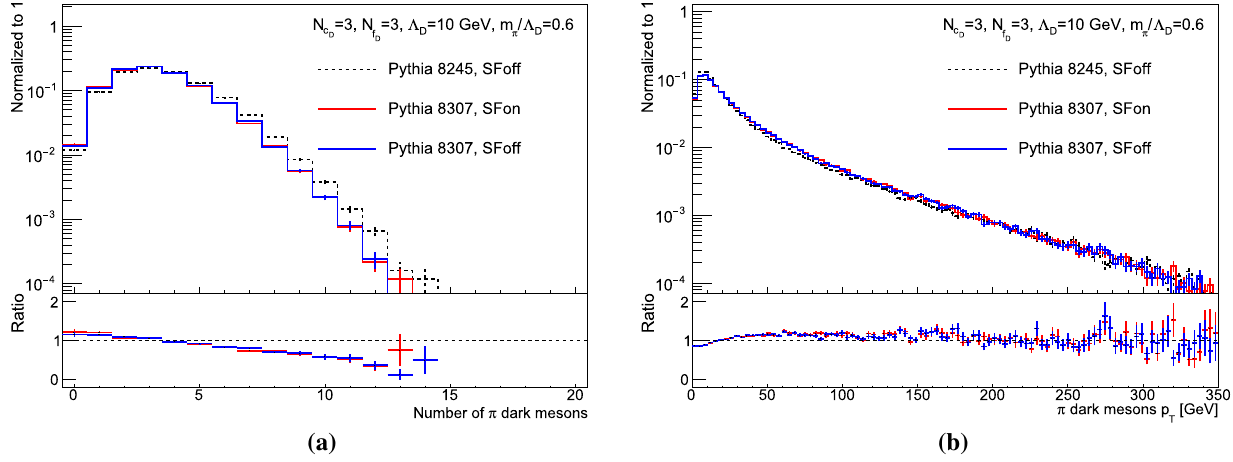
= 3, N = 3 model: a distribution of the number of dark pions, b dark pion p Fig. 29 N c f D D the distributions of the new HV module scenarios to the nominal